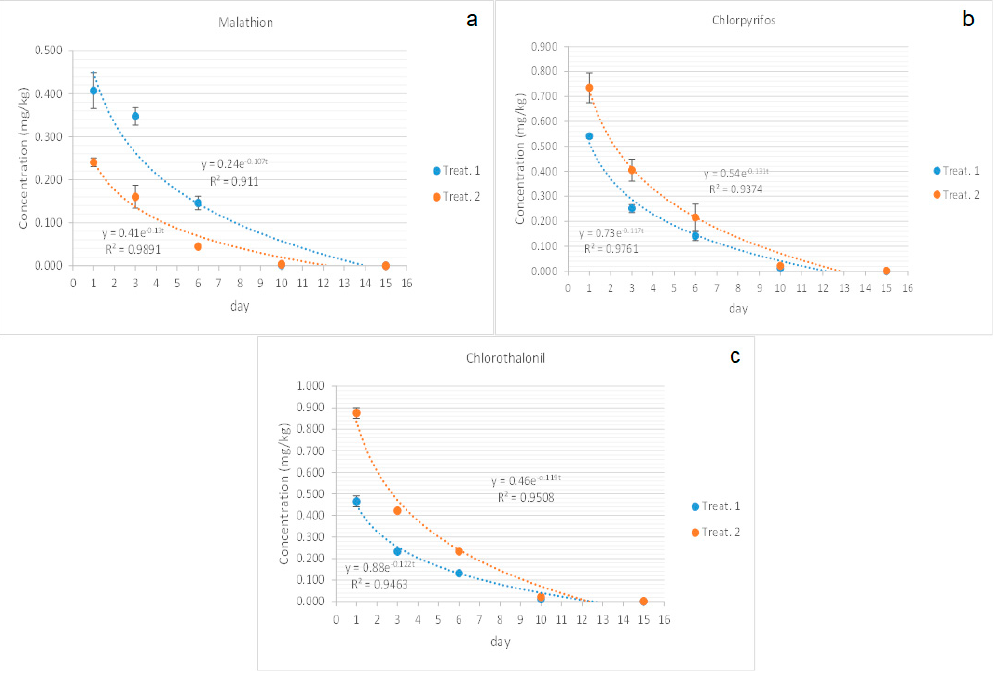
Figure 2. Dissipation curves for pesticides applied in two doses in nopal in Morelos, Mexico; ( a